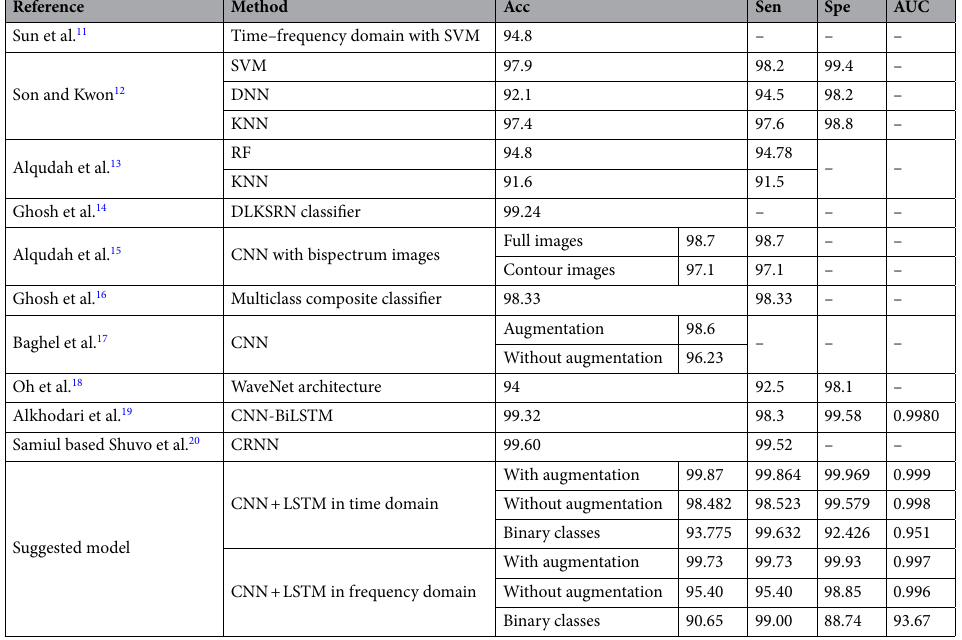
Table 12. Comparison between related work and the proposed method using the open heart sounds dataset.